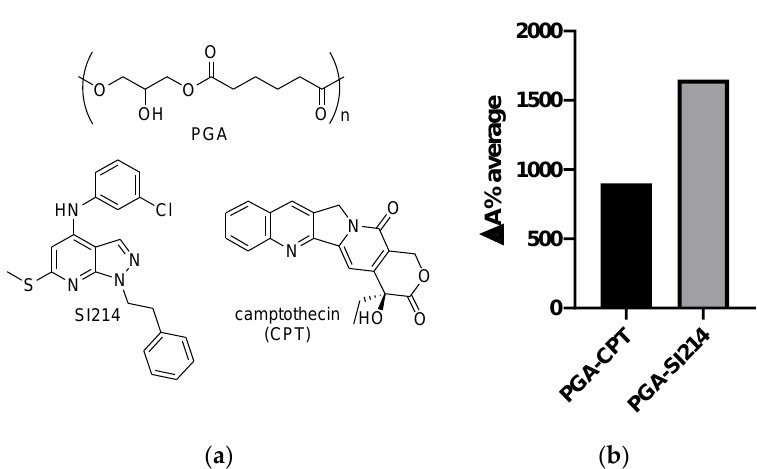
Figure 1. ( a ) Poly(glycerol-adipate) (PGA) (above), SI214, and Camptothecin (CPT) (below) structures; ( b ) ΔA% average of the two nano-formulations calculated against the pure drugs in